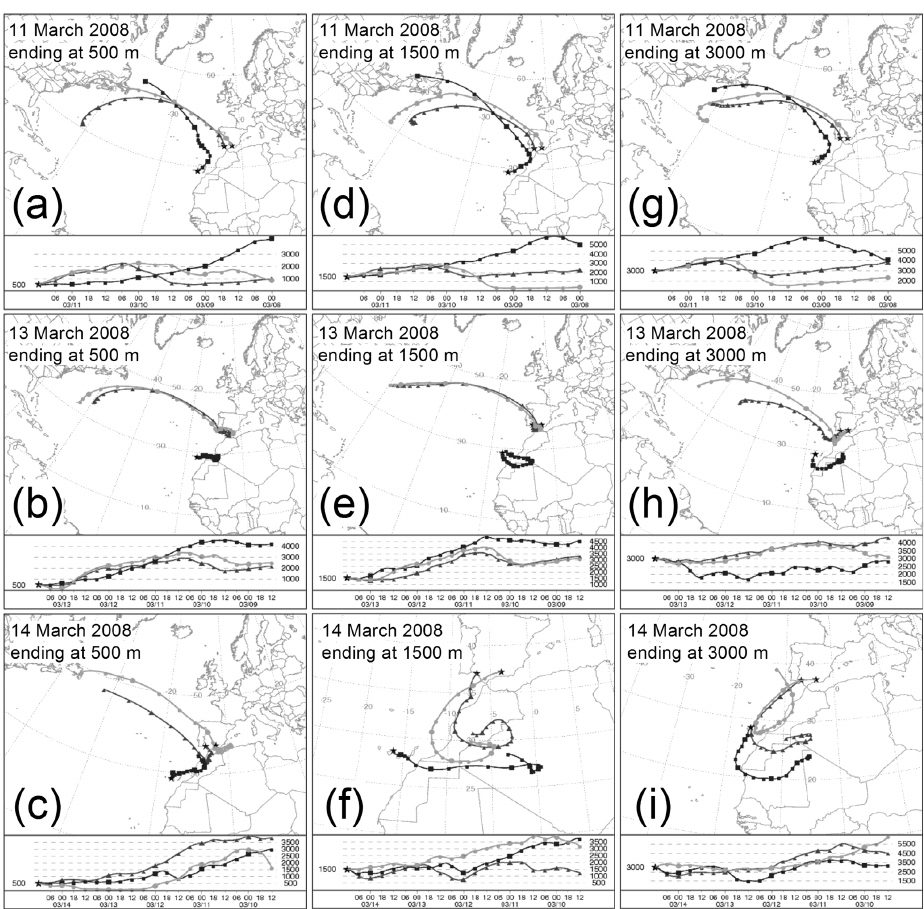
Fig. 5. HYSPLIT 5-day backtrajectories ending at 12:00UTC over SCO (square black line), ARN site (triangle grey line) and GRA (circle black line) sites at different altitudes (a.g.l.): 500m (a-c) , 1500m (d–f) and 3000m (g–i) . Figure panels correspond to three different dates as representative of both non-dusty and dusty conditions depending on each station (see legends inside each